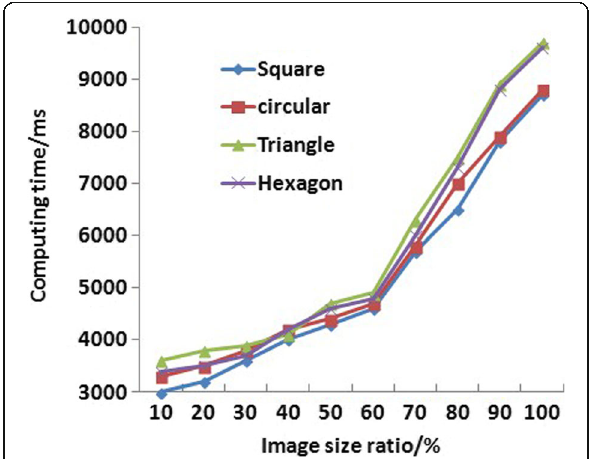
Fig. 11 The relationship between the positioning time and image size of different shape